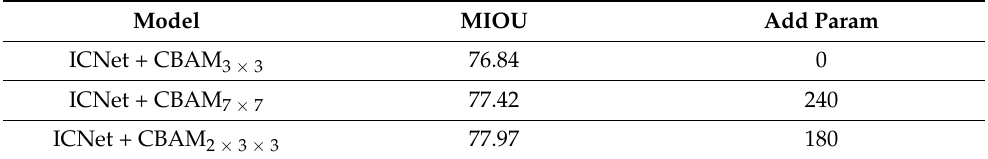
Table 5. Replace the 7 × 7 convolution in the spatial attention in CBAM with a different convolution.